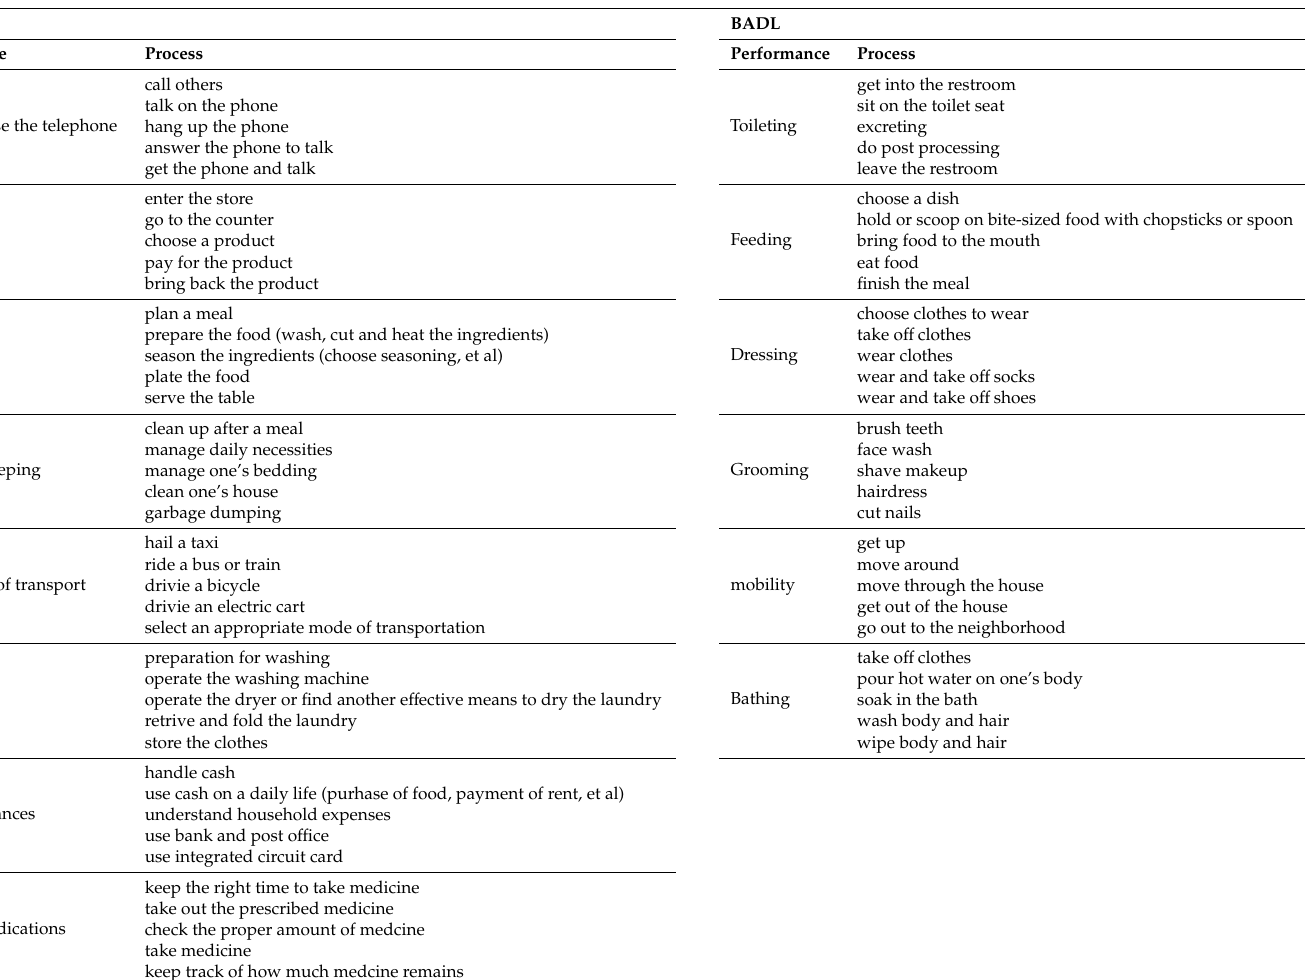
Table 1. List of process of